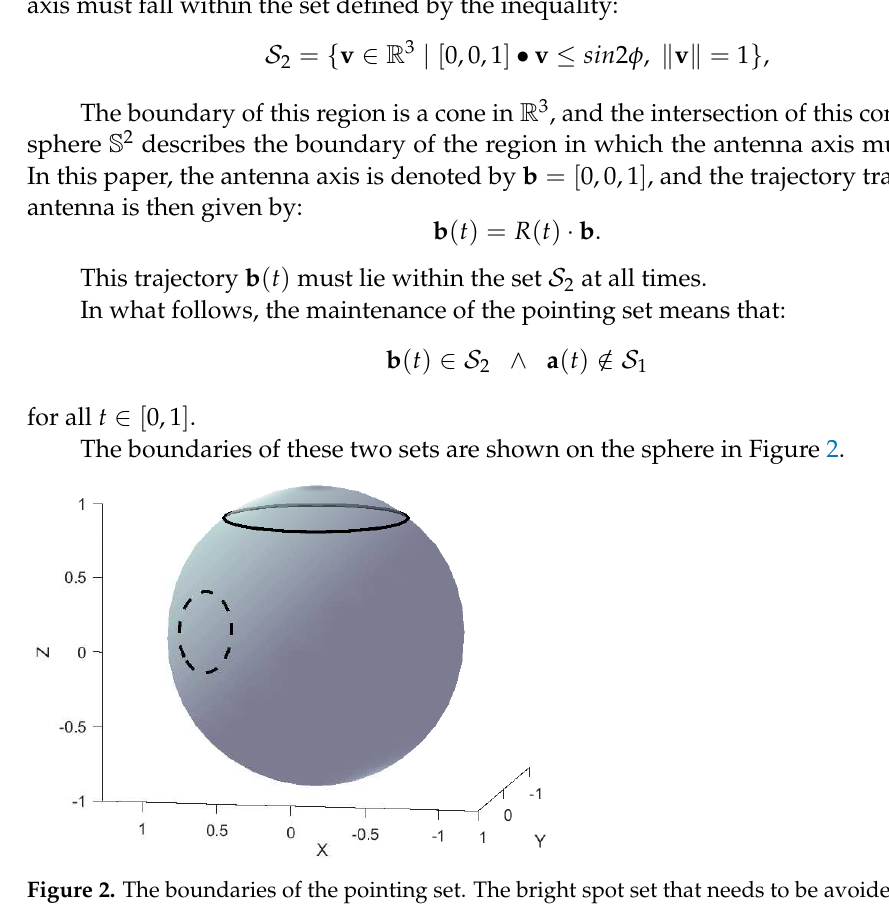
Figure 2. The boundaries of the pointing set. The bright spot set that needs to be avoided ( S 2 ) is the interior of the sphere with the dashed boundary, while the set where the antenna needs to remain ( S 1 ) is the interior of the sphere with the solid